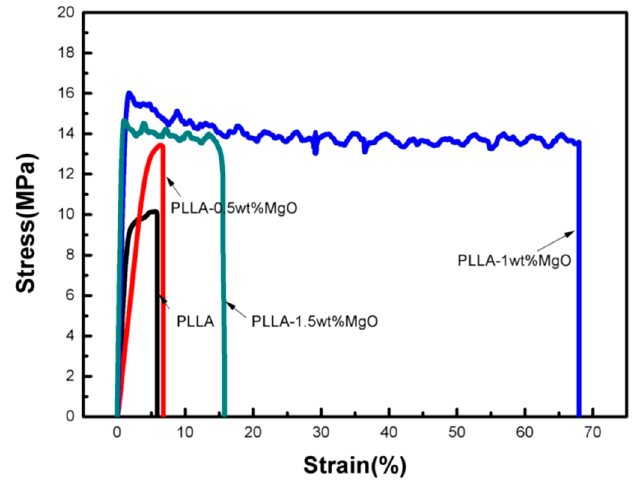
Figure 9. Mechanical properties of PLLA and PLLA–MgO